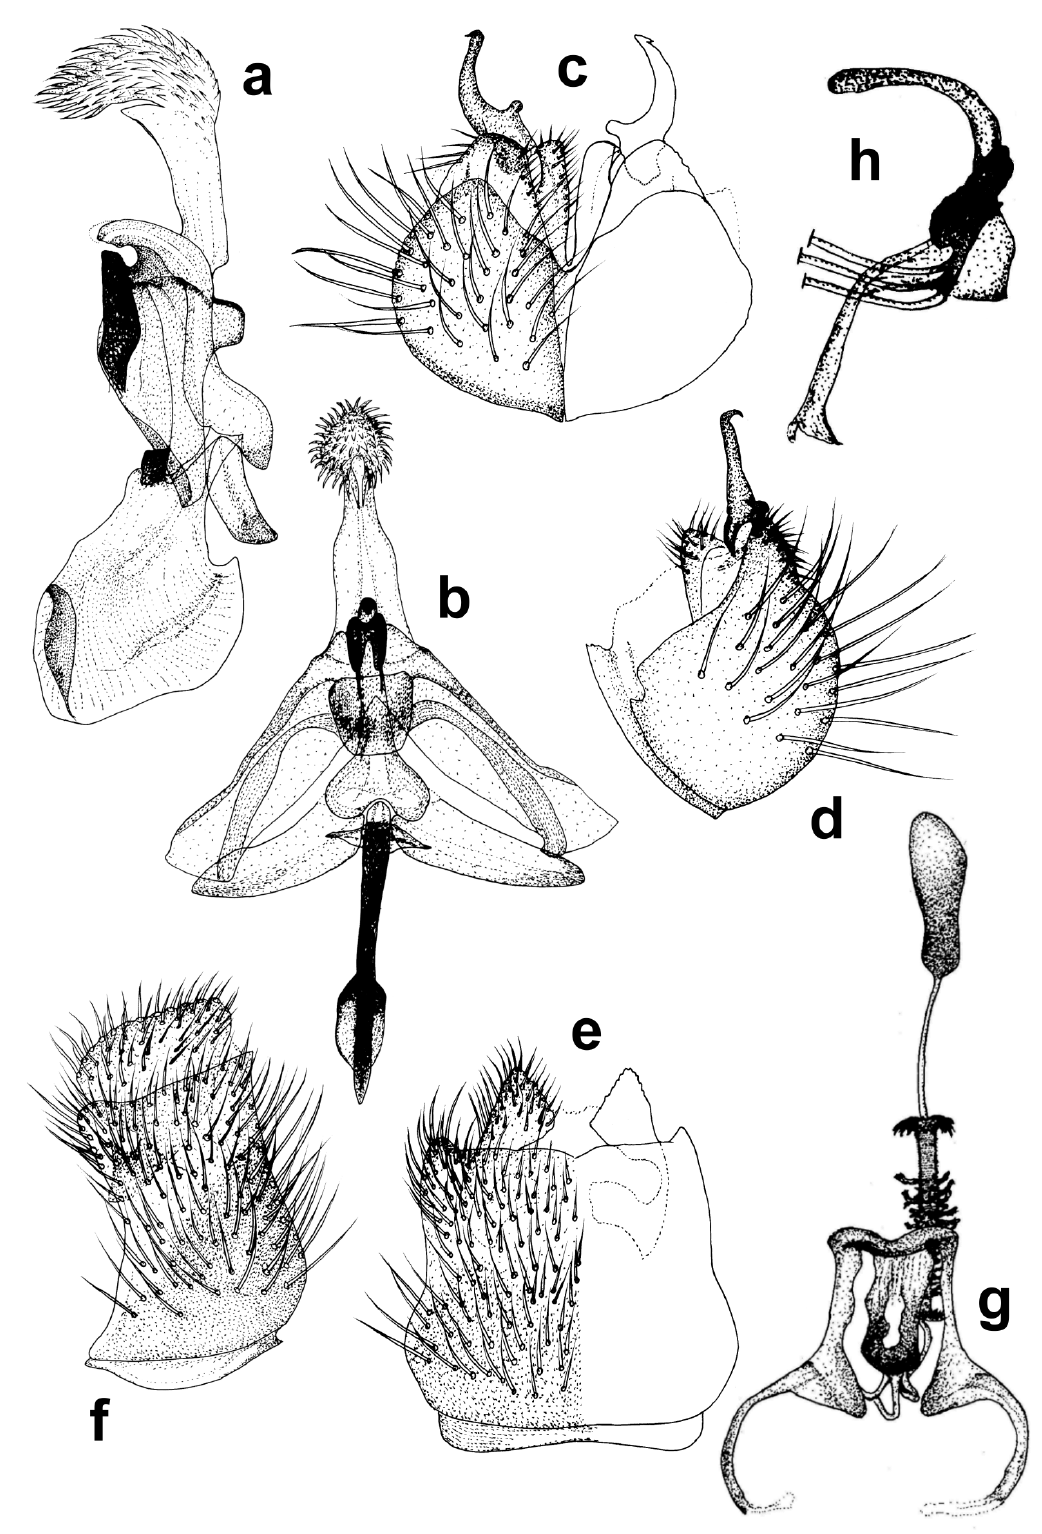
Fig. 50. Protypusia kerkini gen. et sp. nov. a . Epiphallic complex ventral. b . Epiphallic complex lateral. c . Gonocoxite ventral. d . Gonocoxite lateral. e . Epandrium dorsal. f . Epandrium lateral. g . Female genitalia ventral. h . Female genitalia